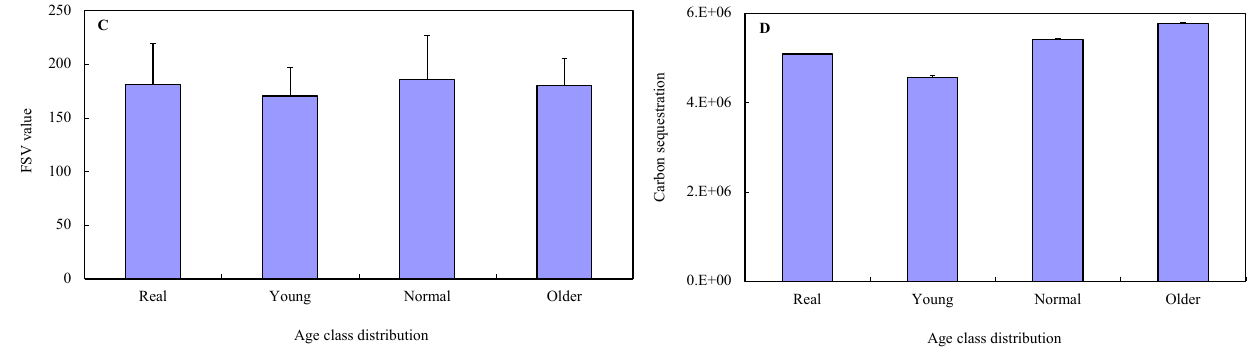
Figure 3. The results of planning for 30-year time horizons of the four forest landscapes with different age class distributions; ( A ) total harvest volume; ( B ) sub-period harvest volume, ( C ) forest spatial value; ( D ) carbon stocks.